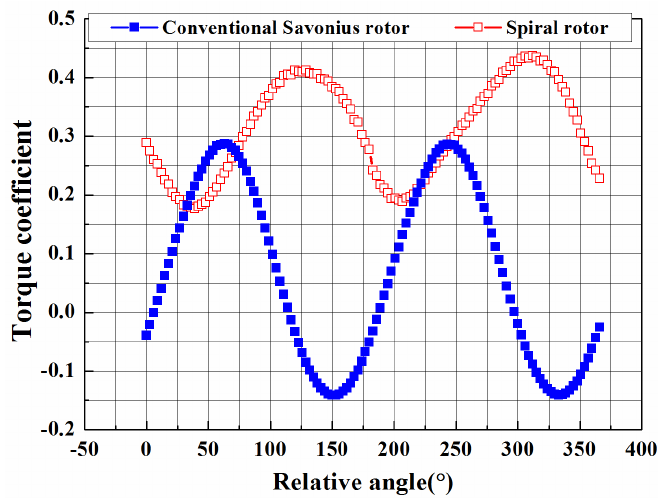
Figure 2. Comparison of torque